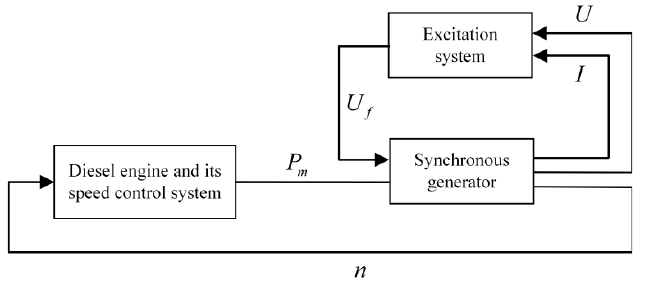
Figure 2. Schematic diagram of the diesel engine system.